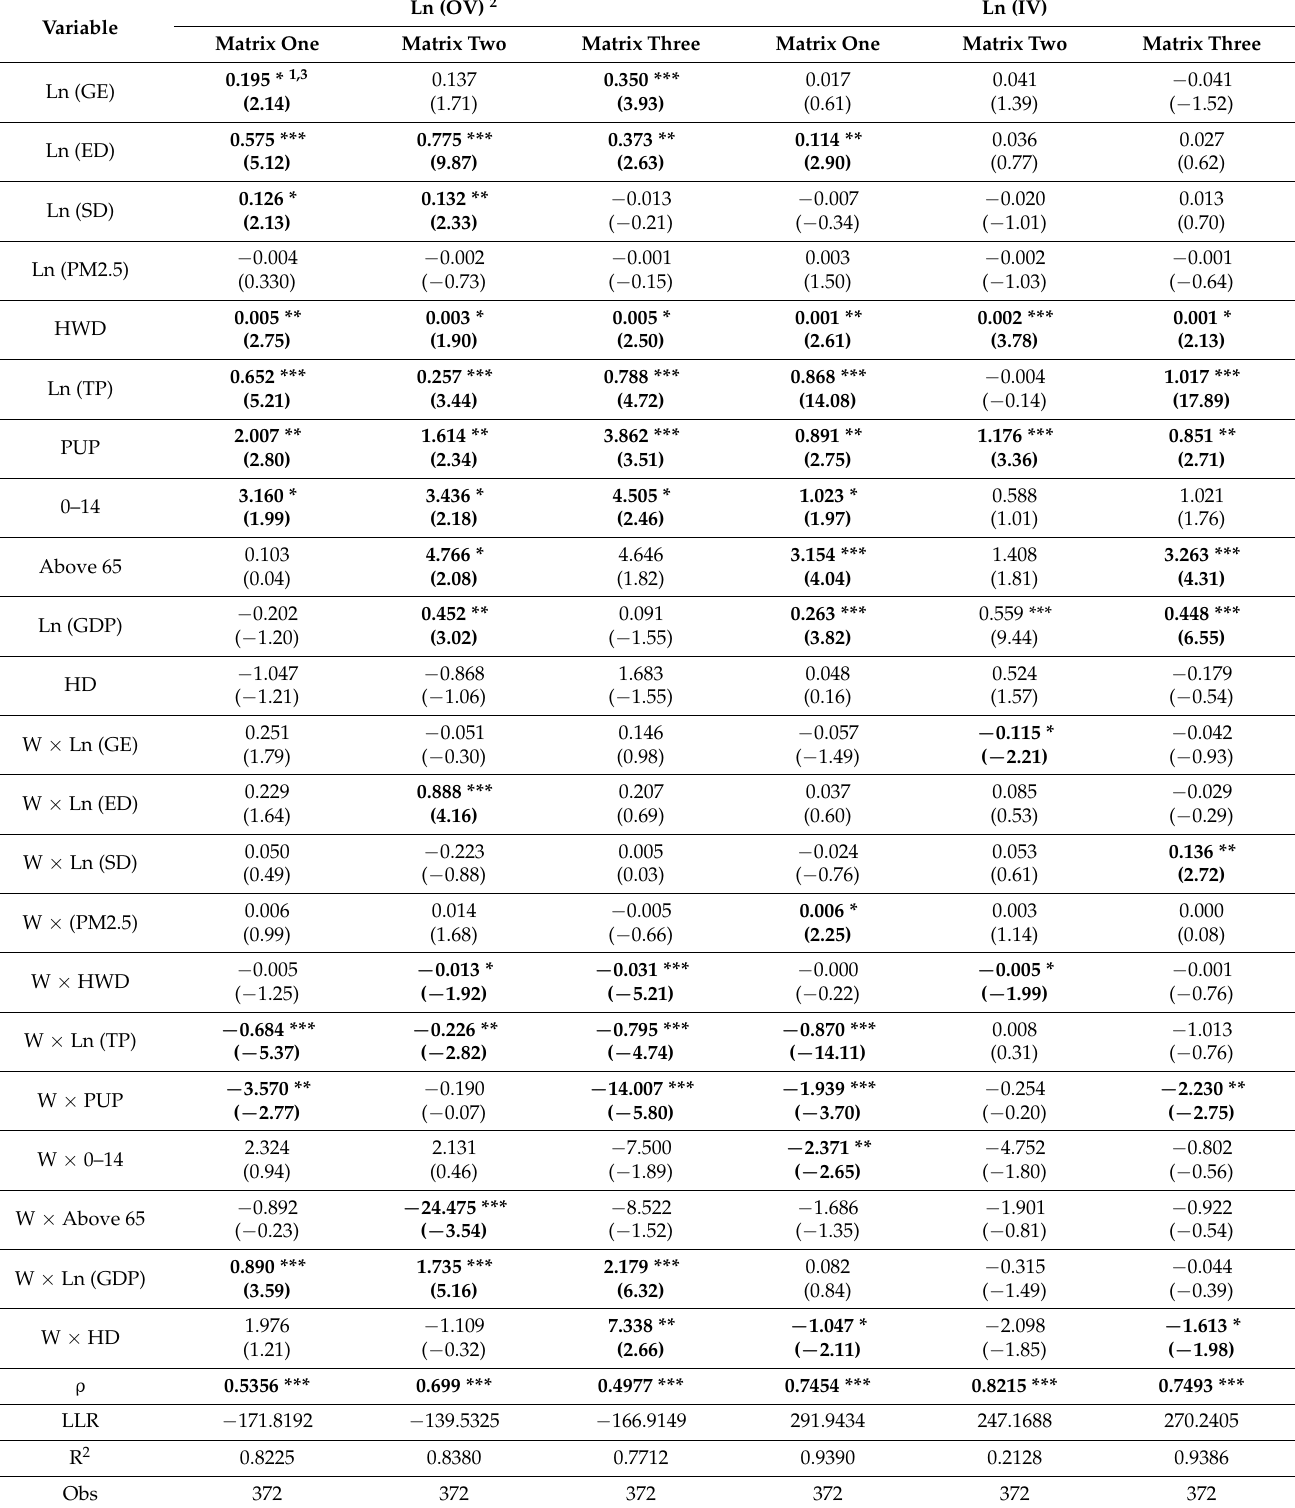
Table 5. Empirical results of the spatial panel